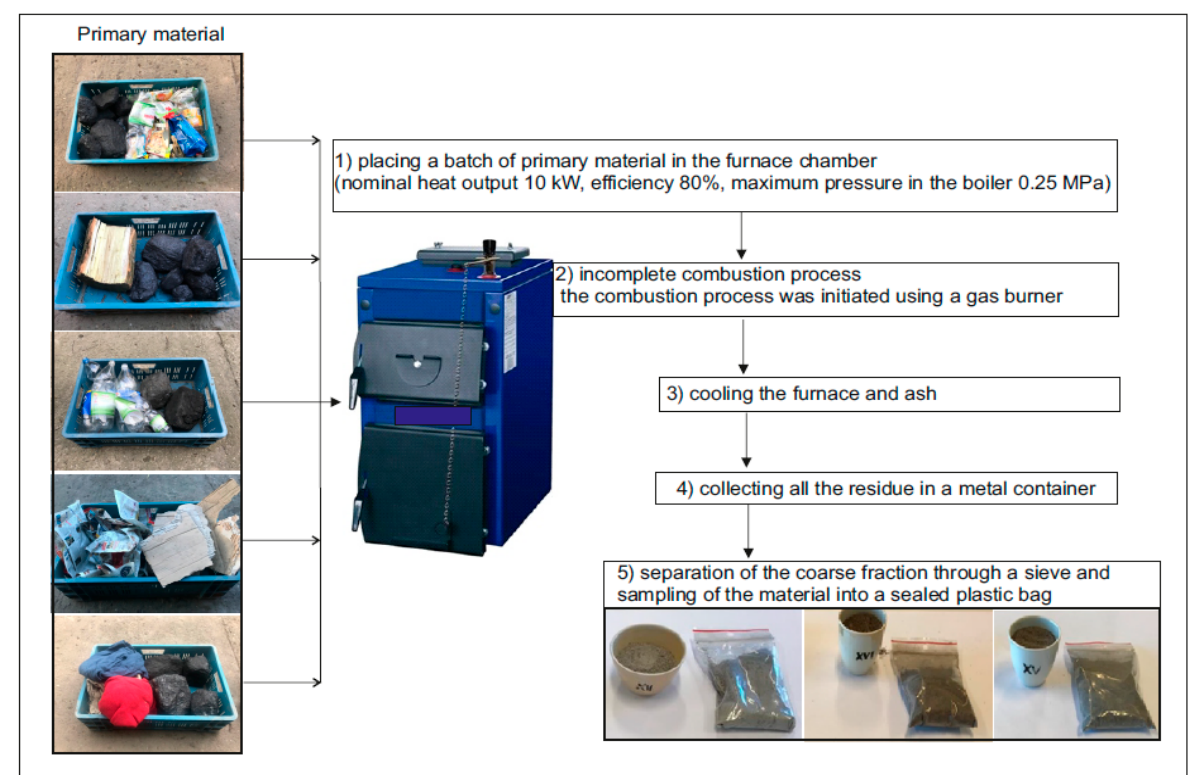
Figure 1. Scheme of fuel combustion in the household furnace.